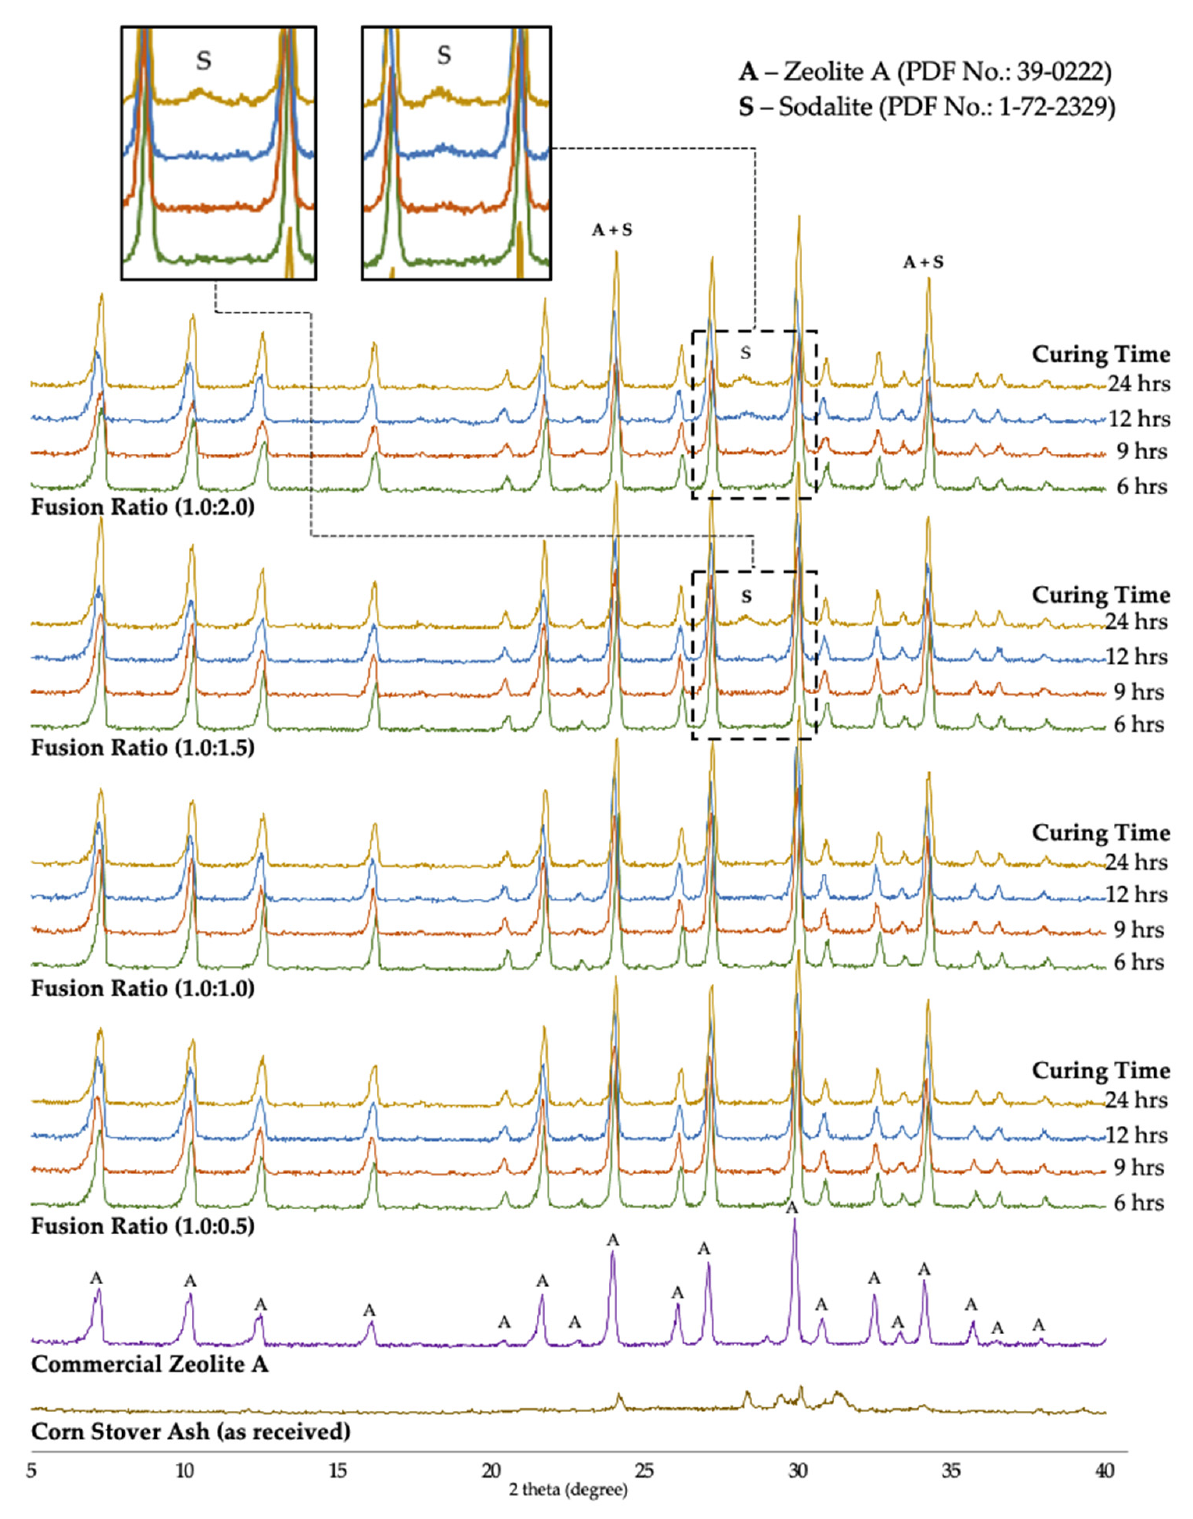
Figure 9. XRD patterns of raw corn stover ash (as received), commercial zeolite A, and synthesized zeolite A under different curing times achieved using different corn stover ash:NaOH